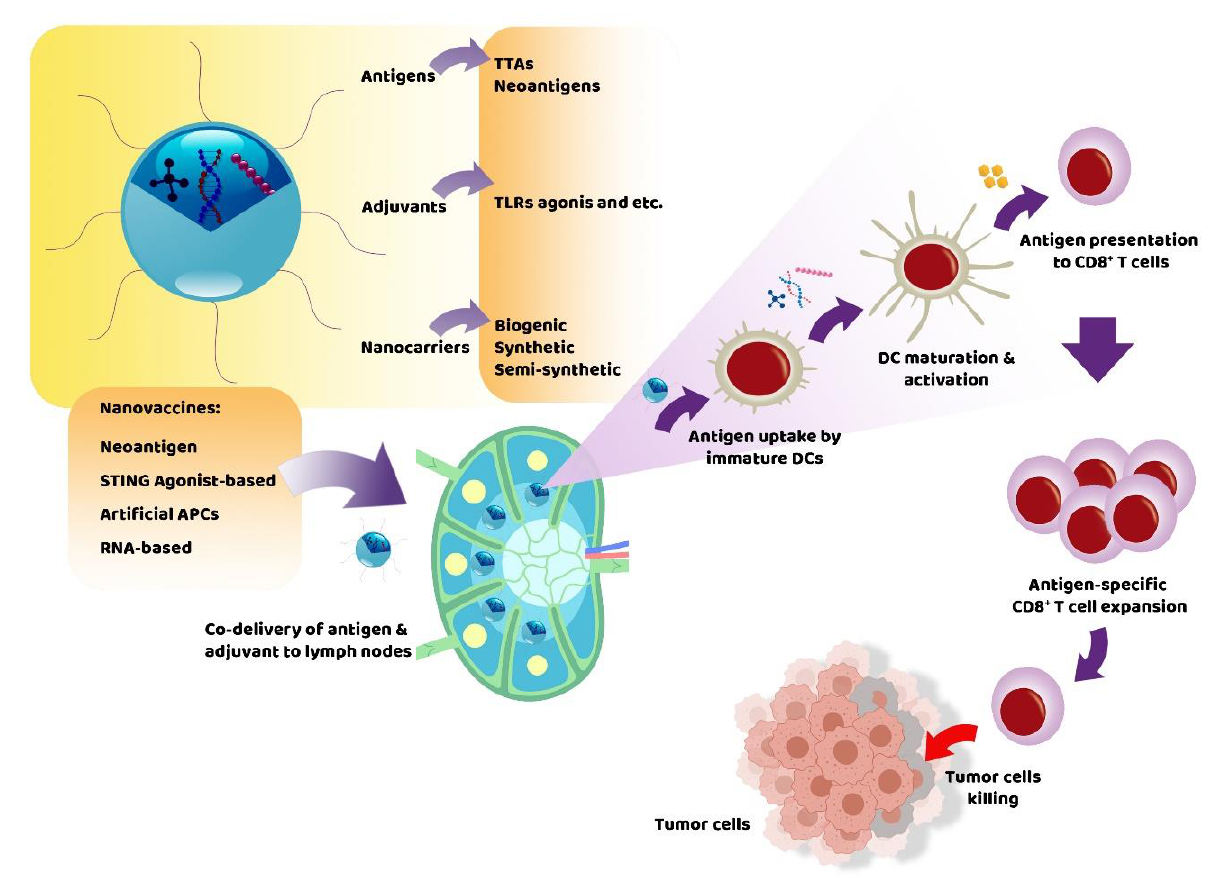
Figure 1. Nanovaccines in the treatment of cancer . The general structure of nanovaccines, their types, and the mechanism of action of this type of vaccine are shown. After administration of nanovaccine and delivery of antigen and adjuvant to lymphoid tissues, antigens are uptake by DCs, resulting in DCs maturation and activation. After this stage, the matured DCs present the antigens to the CD8 + T cells through the MHC molecules and cause T cell expansion. Finally, antigen-specific T cells invade tumor cells in the TME and kill them. APC: antigen-presenting cell; DC: dendritic cell; TAAs: tumor-associated antigens; TLR: Toll-like receptor.